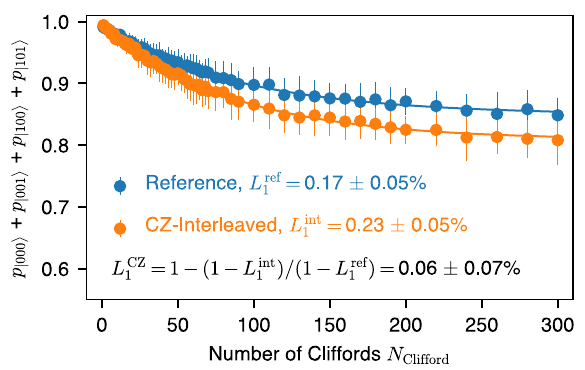
FIG. 33. Characterization of the leakage rate of the CZ gate with an optimized pulse shape. Population in the computational